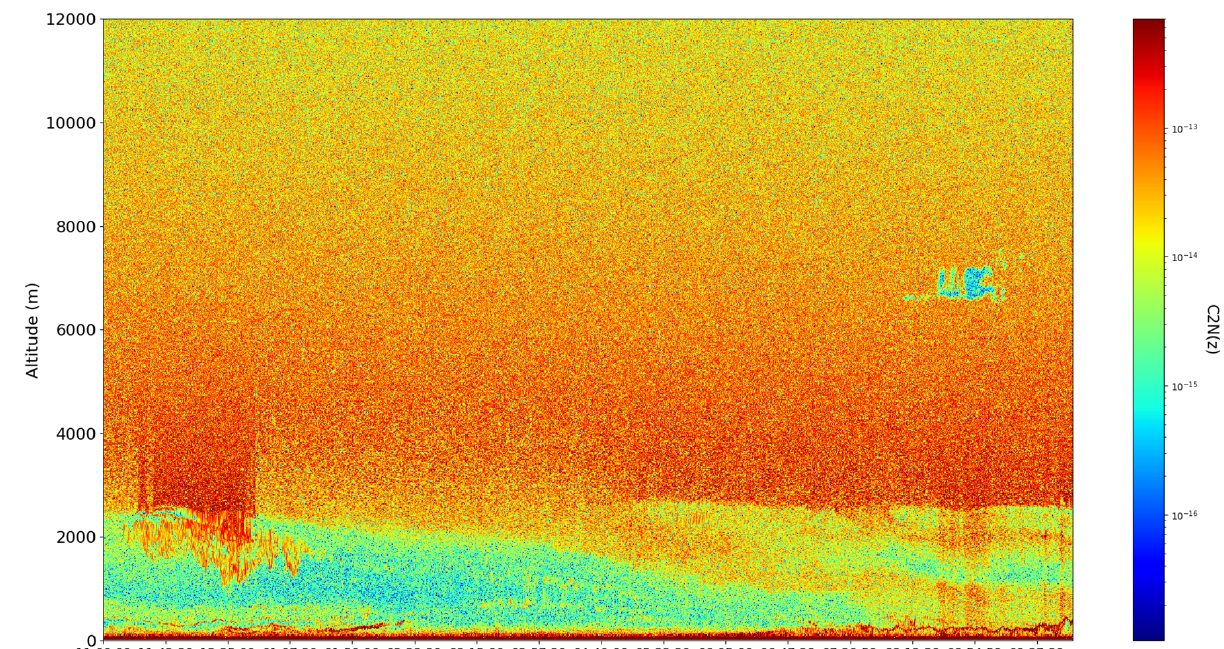
Figure 10. Zoomed-in RCS profile, λ = 1064 nm , Gala ț i, Romania, 22 December 2021. (cid:3118) The coefficient C (cid:2898)(cid:2870) ( m (cid:2879) (cid:3119) ) is commonly used as an indicator of atmospheric turbu- lence strength; it can be also used to more accurately quantify the PBL altitude, and to identify regions of atmospheric calm or extreme turbulence (Figures 11–14) [25].